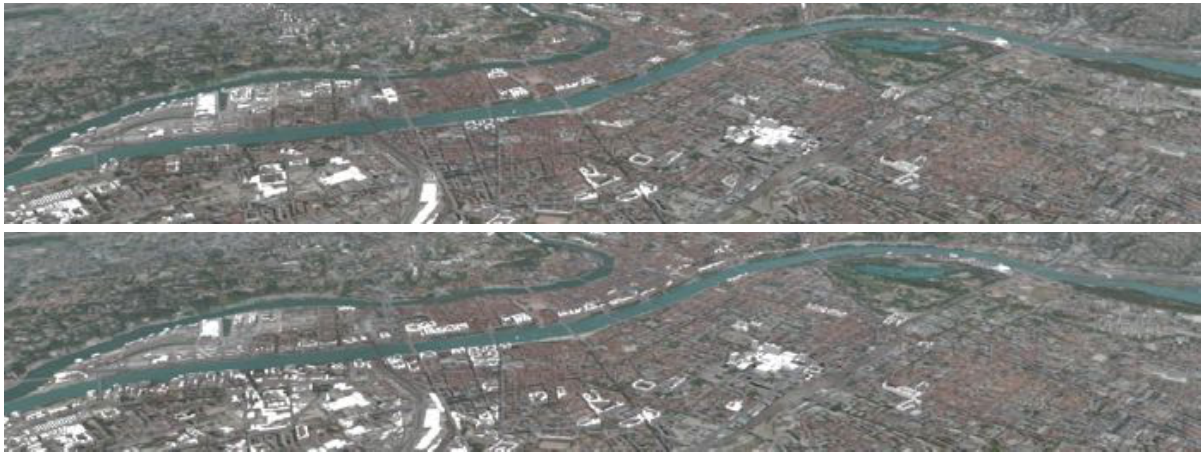
Figure 12: Different weight functions and 500,000 triangles limit. The top image uses W 1 and the bottom one W 3